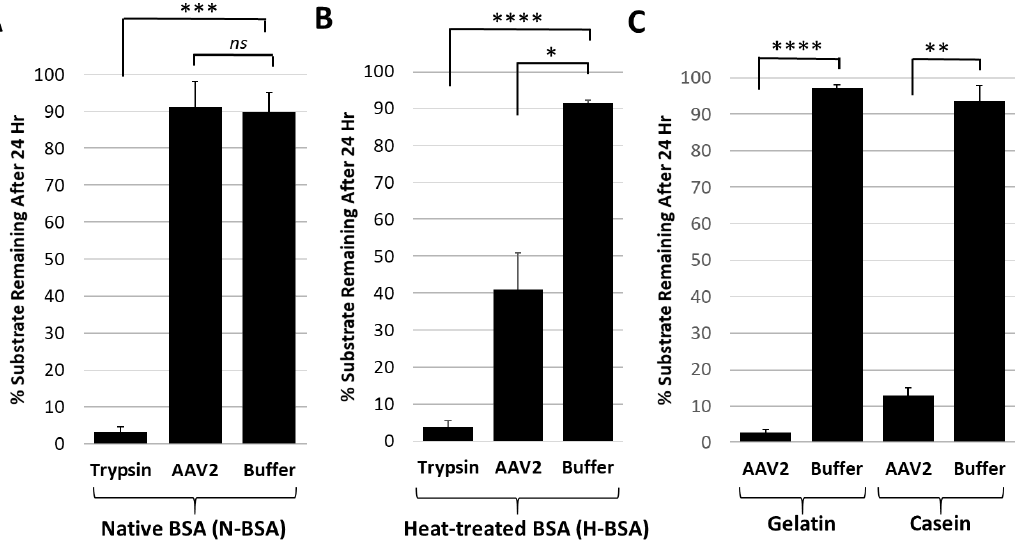
Figure 4. The AAV2 VP1u protease preferentially degrades disordered proteins. ( A ) Quantification of trypsin or AAV2 protease activity against native BSA (N-BSA). The y -axis shows the percentage of substrate remaining after 24 h under the conditions indicated in the x -axis. ( B ) Quantification of trypsin or AAV2 activity against heated BSA (H-BSA). Axes are as defined in (A). ( C ) Quantification of AAV2 activity against casein and gelatin. Axes are as defined in (A). Data for casein was shown in Figure 2. Statistical significance as indicated by asterisk annotations (*) are described in Material and Methods